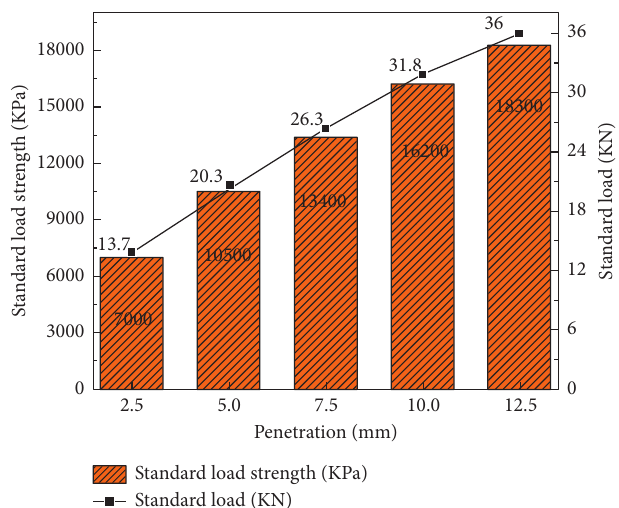
Figure 8: Standard load strength and standard load under different penetration.